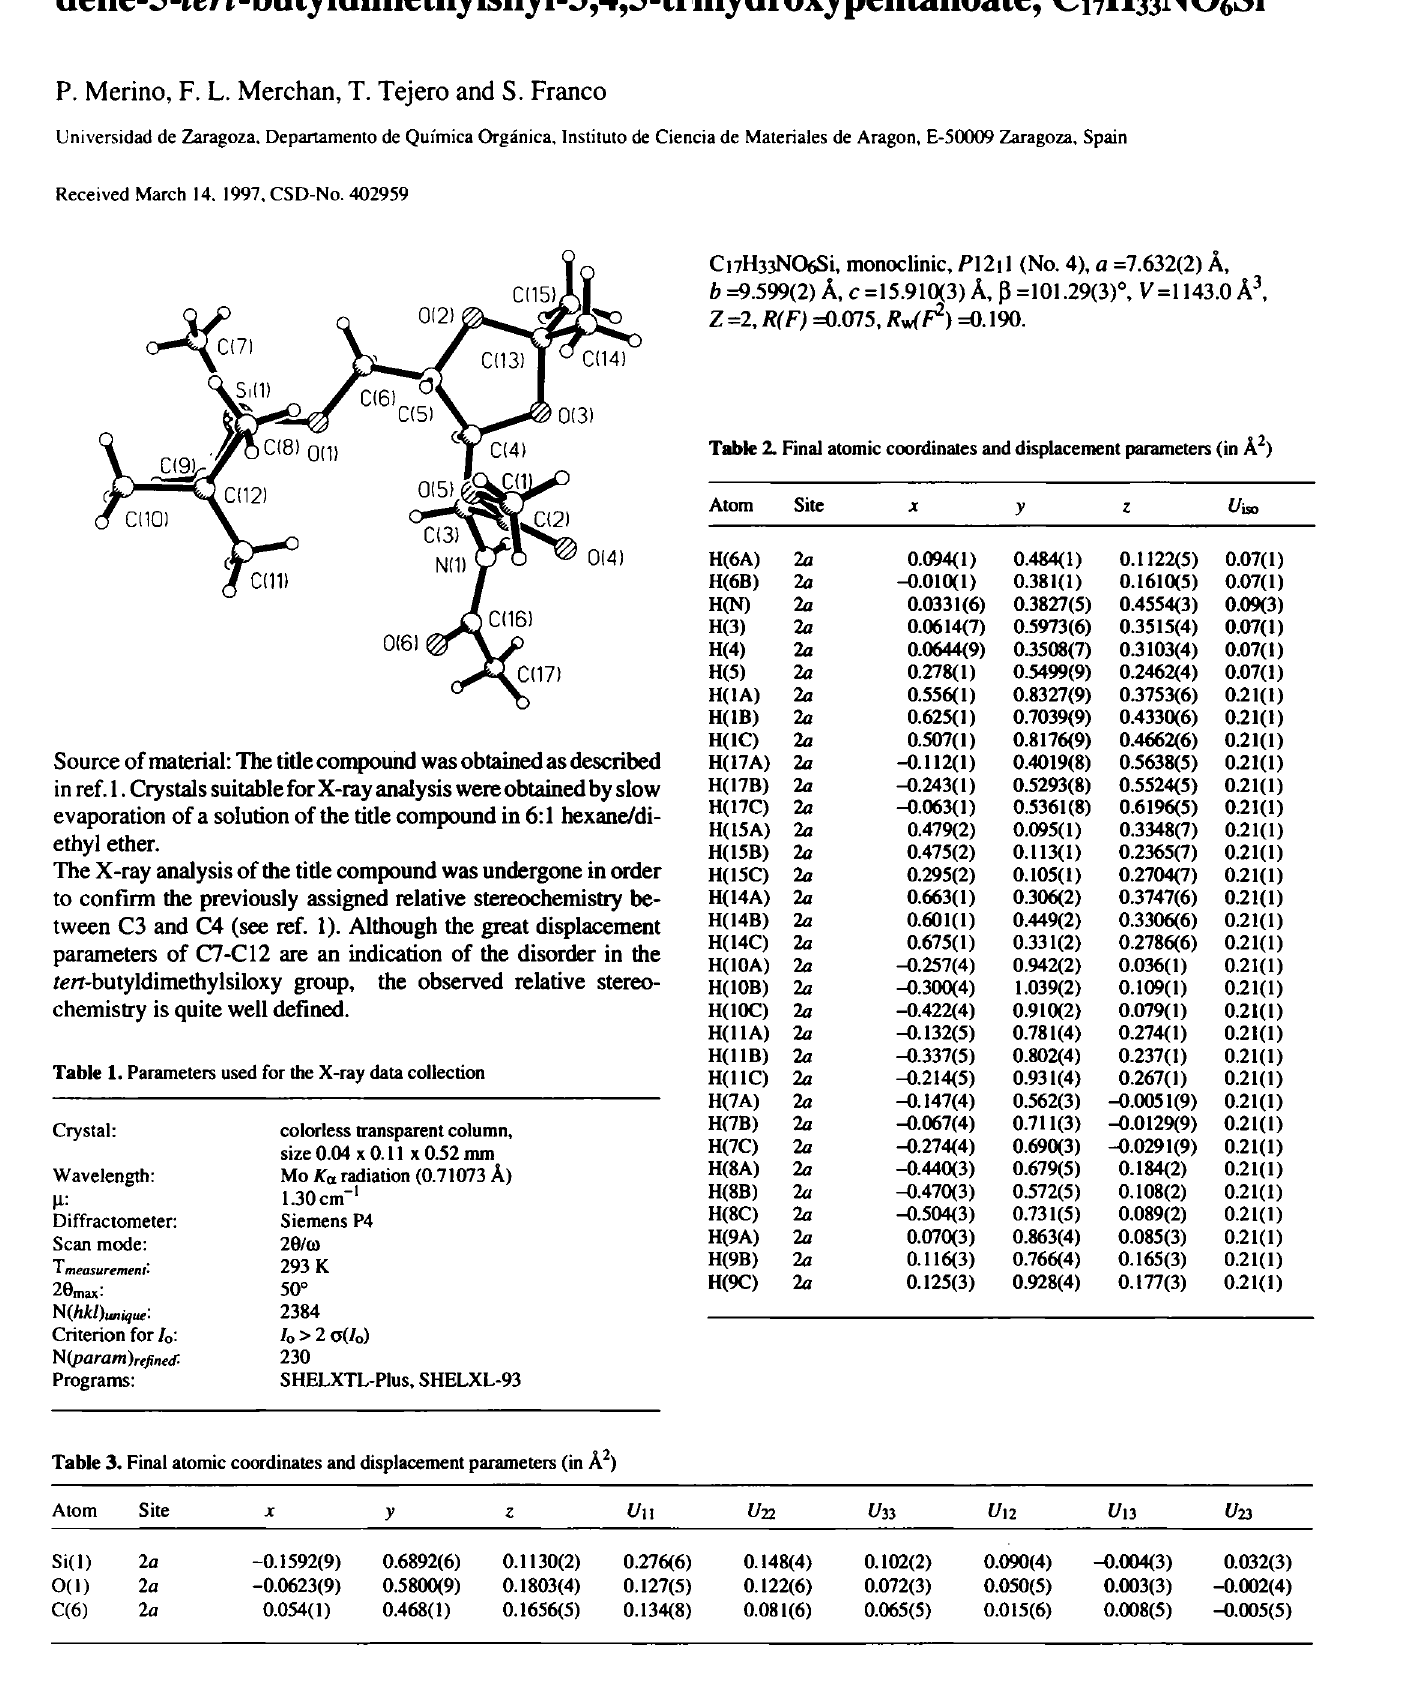
Table 3. Final atomic coordinates and displacement parameters (in